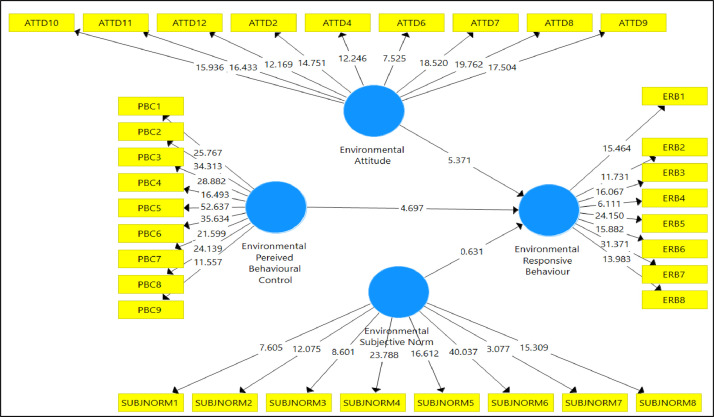
Structural Model.